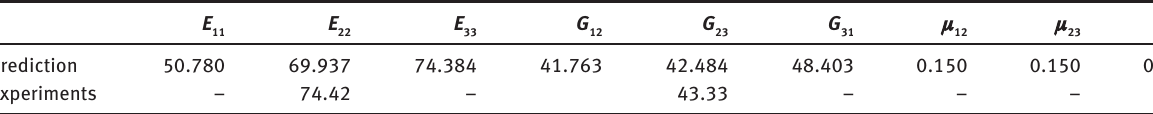
Table 4: Comparison of predicted elastic parameters with experiments.